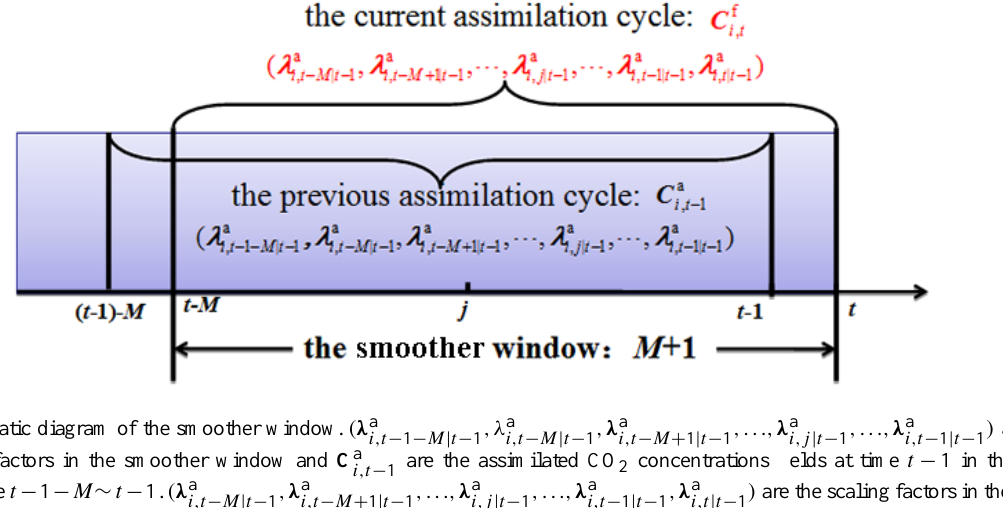
,λ a , λ a ,..., λ a ,..., λ a ) are the op- i,t − 1 − M | t − 1 i,t − M | t − 1 i,t − M + 1 | t − 1 i,j | t − 1 i,t − 1 | t − 1 are the assimilated CO 2 concentrations fields at time t − 1 in the previous i,t − 1 ,..., λ a , λ a ) are the scaling factors in the smoother , λ a ,..., λ a i,t − M | t − 1 i,t − M + 1 | t − 1 i,j | t − 1 i,t − 1 | t − 1 i,t | t − 1